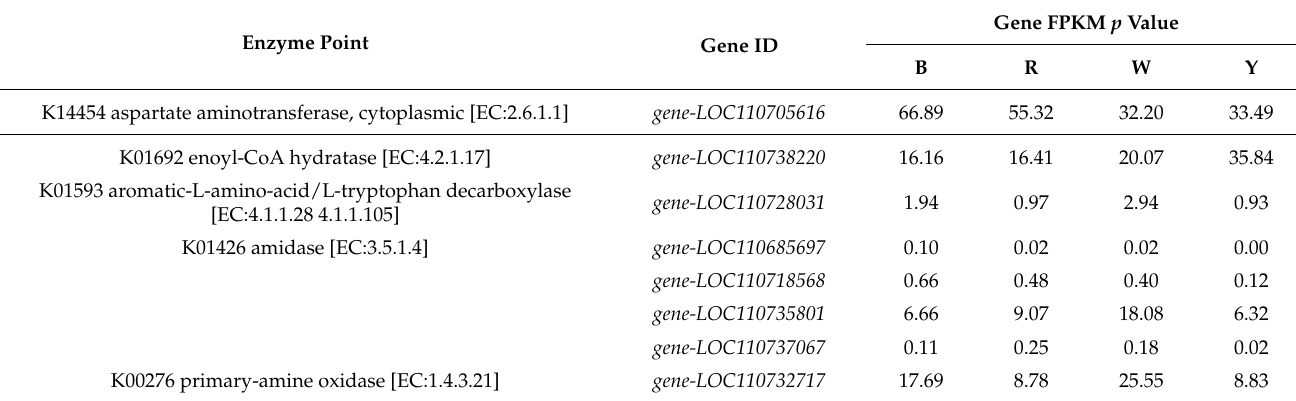
Table 3. Enzyme point and FPKM (fragments per kilobase of transcript per million fragments mapped) value of different quinoa cultivars.